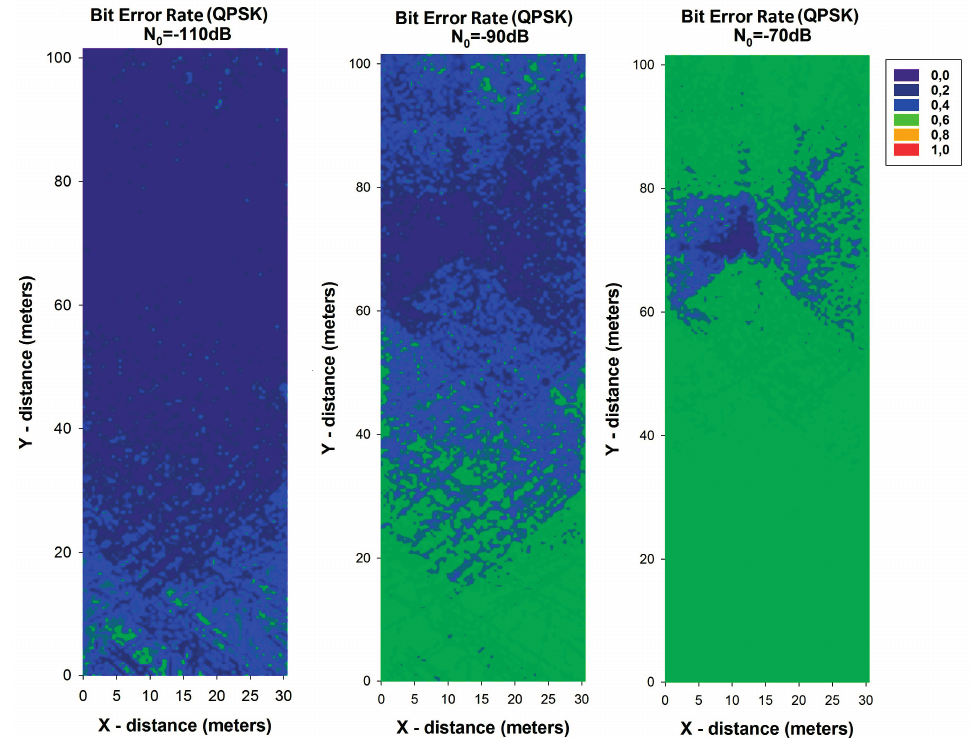
Figure 10. Bit Error Rate for QPSK modulation for different values of N 0 for data rate of 250 Kbps.